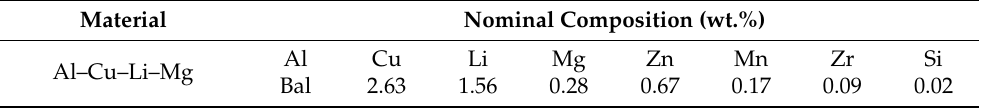
Table 1. The nominal composition of gas-atomized Al–Cu–Li–Mg